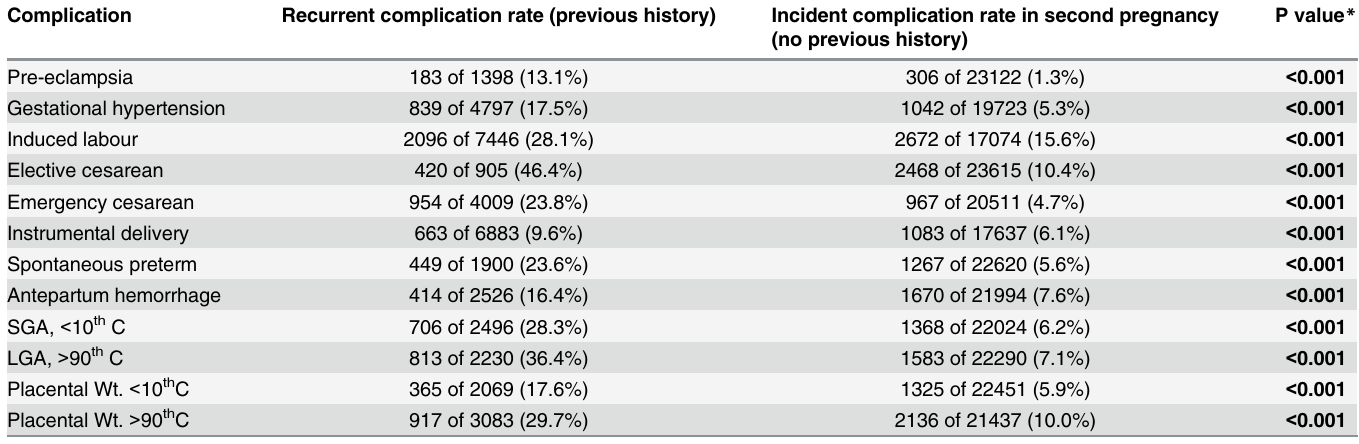
Table 3. Frequency of recurrent pregnancy complications in women with previous history compared with incident rate in second pregnancy in women with no previous